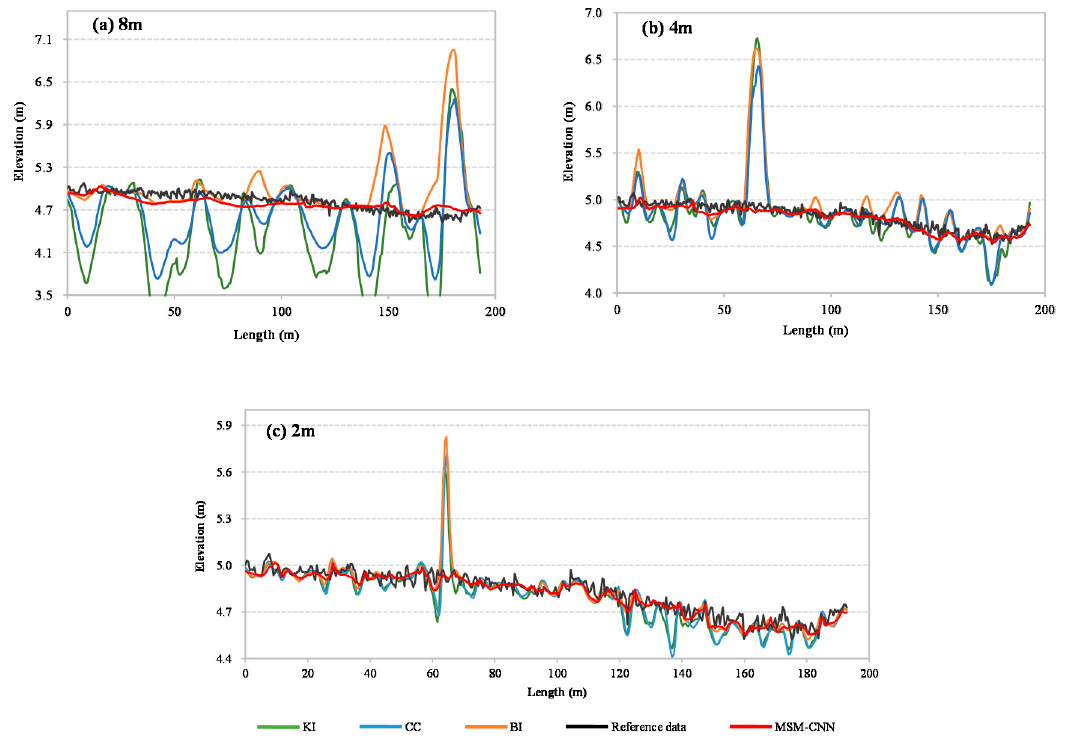
Figure 10. Road profiles extracted from the DEMs reconstructed using different methods: ( a , b , c ) the road profiles from the 8, 4, and 2 m reconstructed DEMs, respectively.